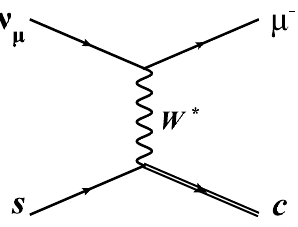
Figure 1 . LO diagram for charm quark production through weak charged current in DIS. The thick solid line denotes the charm